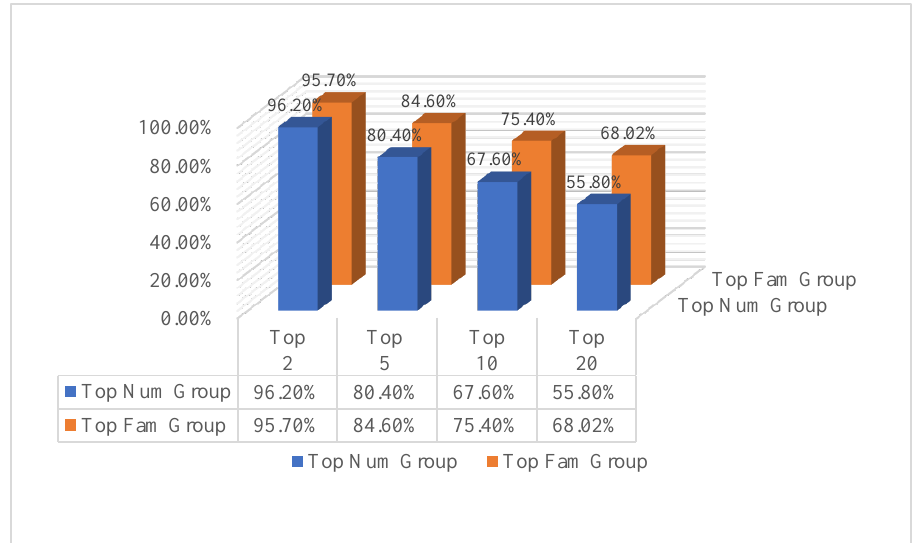
Figure 12. Effectiveness of the text acceptance component.